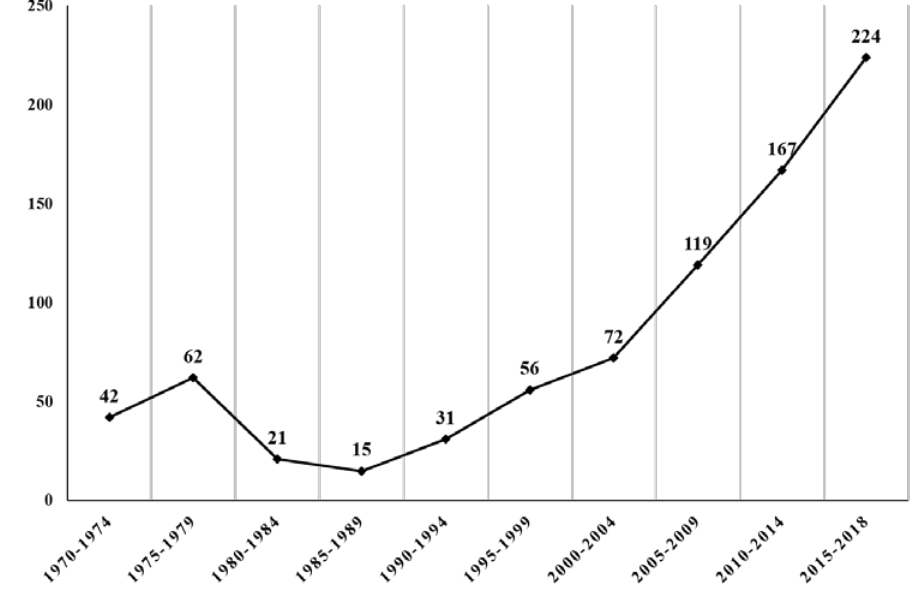
Figure 1. Diachronic output on OUs organized in periods of five